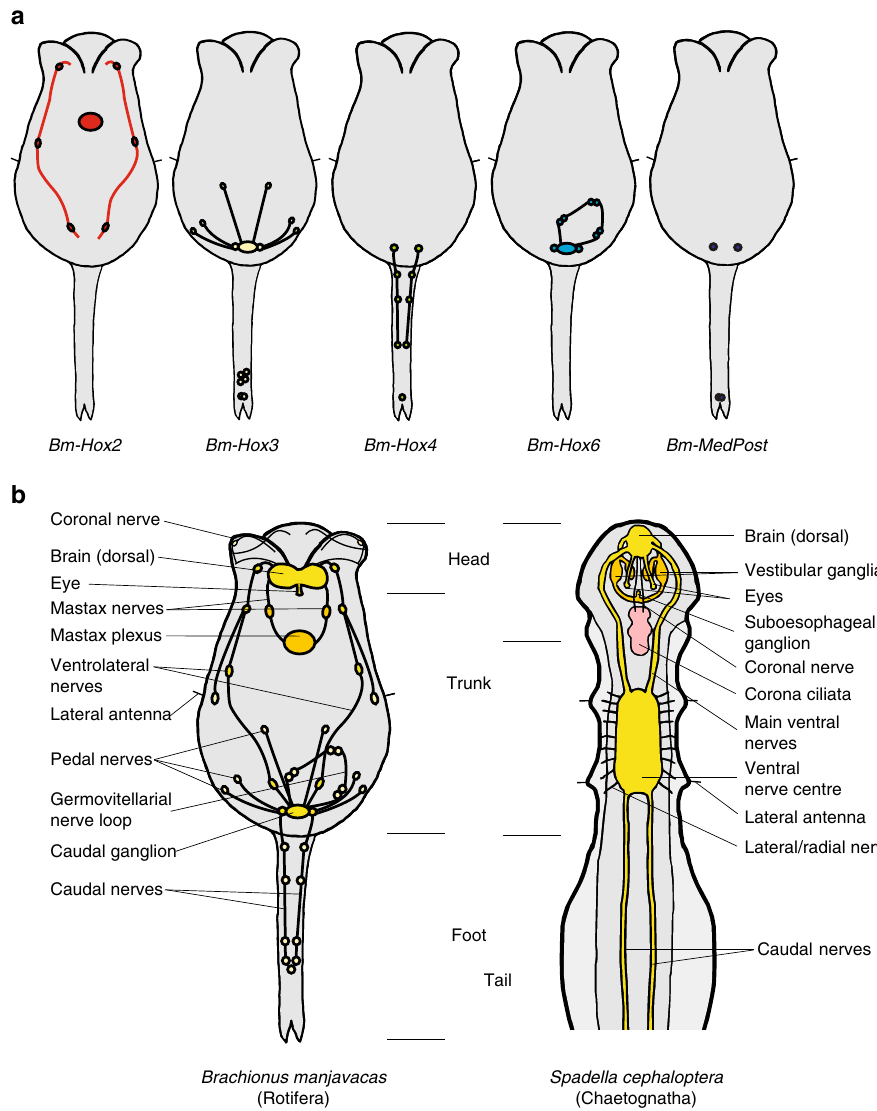
Fig. 3 Body plans and nervous systems in Rotifera and Chaetognatha. a Diagram of Hox gene expression in the nervous system of Brachionus manjavacas . b Comparison of rotiferan and chaetognath body plans with respect to the structure of the nervous system. Both groups have a dorsal brain and additional nerve plexi: mastax nerves and ganglia in rotifers and vestibular, and esophageal ganglia in chaetognaths as well as a caudal ganglion in rotifers and a ventral nerve centre in chaetognaths with the latter possibly incorporating functional subsets, these are still separated from the caudal ganglion in